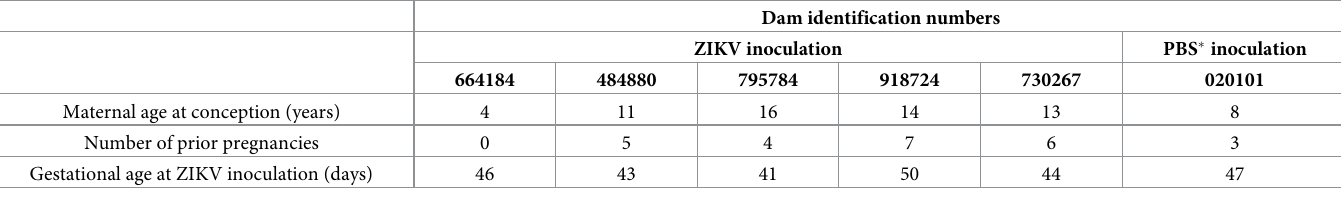
Table 1. Characteristics of the dams inoculated with ZIKV or